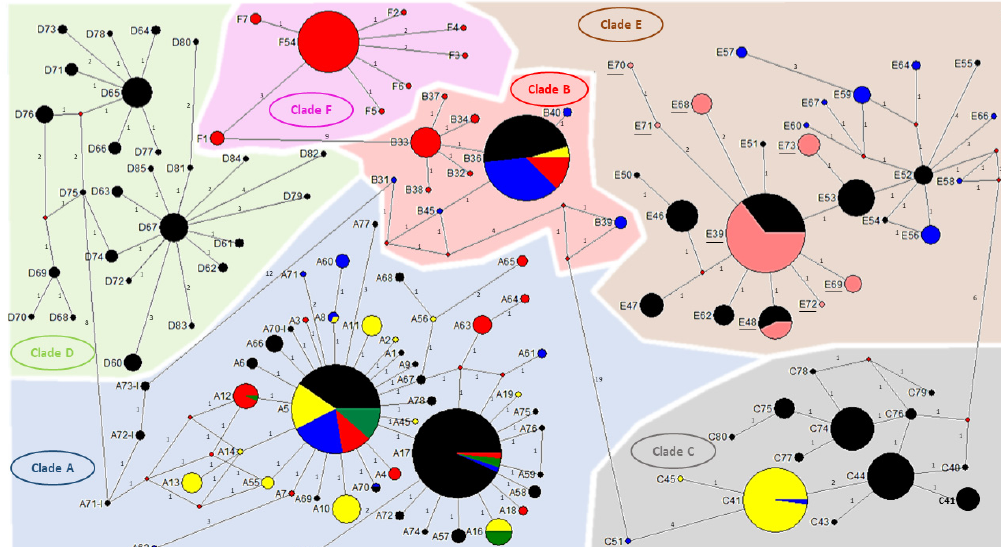
Figure 3. Cytb haplotype networks of human body and head lice including our samples. Each circle indicates a unique haplotype, and variations in circle size are proportional to haplotype frequencies. Pie colors and sizes in circles represent the continents and the number of their sequence for a haplotype. The length of the links between nodes is proportional to the number of mutations. The types of haplotypes identified in this study are underlined. Besides, all P. humanus lice were tested by multiplex qPCR targeting the PHUM540560 gene to investigate their ecotype; this method was used previously to distinguish between head and body lice belonging to clade A [41]. All our specimens were collected by the patients from their scalp hair, and belong to clade E. Using the multiplex qPCR method; all the 155 Guinean head lice specimens exhibited a FAM-labeled probe amplification specific to the body lice profile. These results confirm the fact that the PHUM540560- multiplex qPCR is a restricted molecular tool to differentiate only between clade A-human lice. Based on these data, we proceeded with the analysis of the PHUM540560 gene sequences of our samples and those belonging to clade A reported in the literature [41]. For this purpose, diverse human lice specimens encompassing both ecotypes were randomly selected from our lice collection. These samples were then subjected to standard PCR and sequencing of the targeted PHUM540560 gene. The obtained sequences were aligned with sequences of body and head lice. Alignment was conducted using the BioEdit v 7.0.5.3 software (available online: http://en.bio-soft.net/format/BioEdit.html). The rearranged sequences of the clade E Guinean-head lice PHUM540560 gene were revealed and to compared to the polymorphisms of the clade A body and head lice.